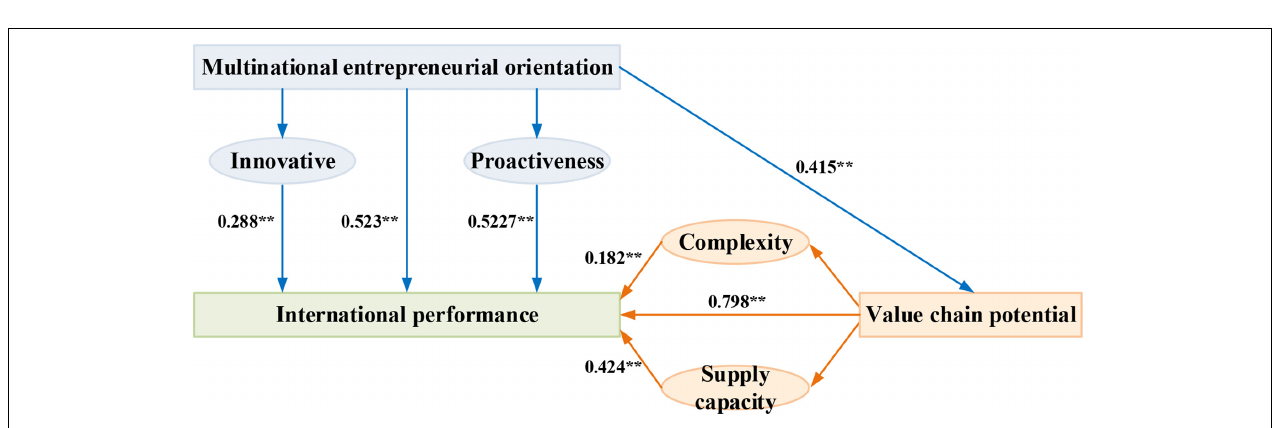
FIGURE 7 | Impact paths of the economic pressure and social support based on the trade friction on the thought of entrepreneurial recession. ** represents P < 0.01.